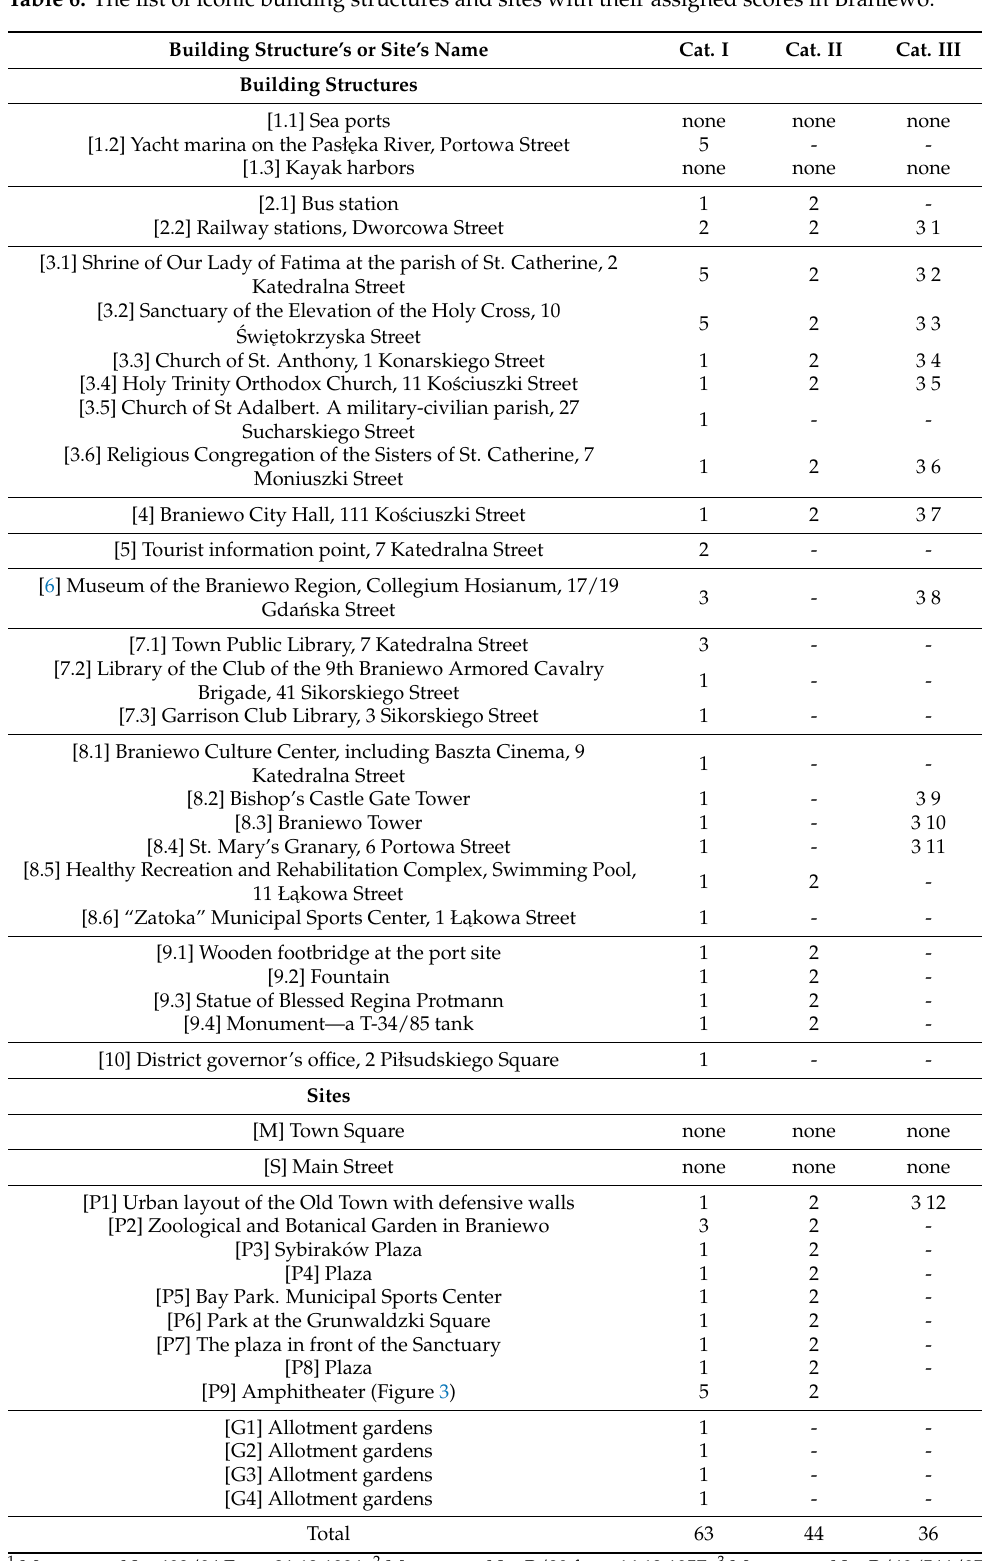
Table 6. The list of iconic building structures and sites with their assigned scores in